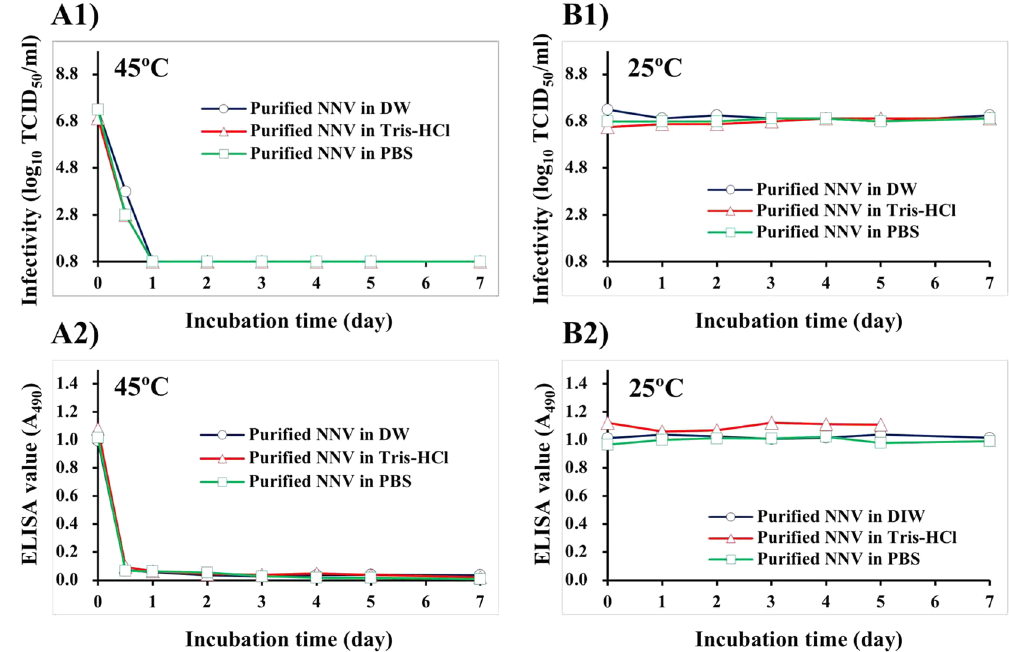
Figure 3. Effect of purified NNV particles suspended in DIW, Tris-HCl (15 mM, pH 8.0), or PBS on infectivity and antigenicity. Purified NNV particles suspended in each buffer were incubated at 45 °C or 25 °C for 7 days. ( A ) Incubation at 45 °C, ( B ) Incubation at 25 °C (control). (1) Alteration in infectivity of purified NNV particles suspended in DIW, Tris-HCl, or PBS, (2) Alteration in antigenicity of purified NNV particles suspended in DIW, Tris-HCl, or PBS.